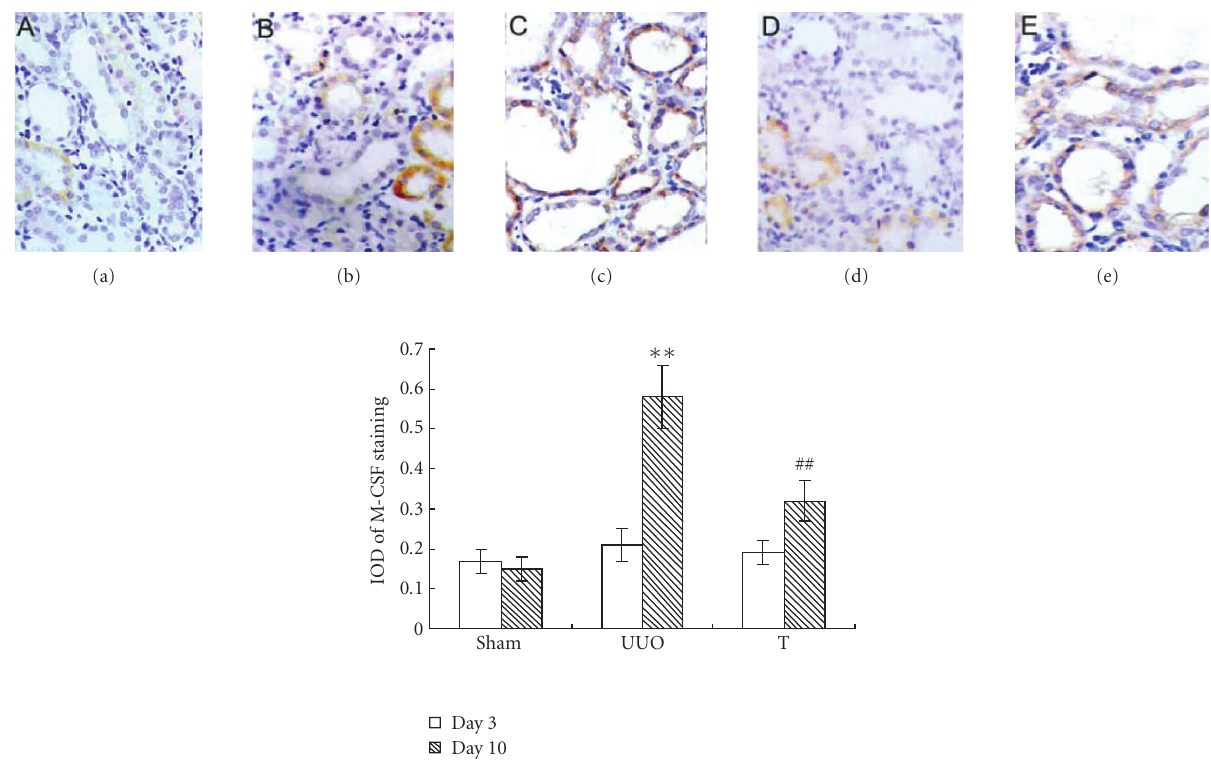
Figure 5: Staining of M-CSF at di ff erent time points in di ff erent groups by immunohistochemistry ( × 200) . Using antibody against M-CSF, sections were stained by immunohistochemistry. Labeling index was expressed by integral optical density (IOD): (a) sham group, (b) UUO on day 3, (c) UUO on day 10, (d) treatment group on day 3, and (e) treatment group on day 10. ∗∗ : P < . 01 versus sham group of the same time point. ##: P < . 01 versus UUO group of the same time point.